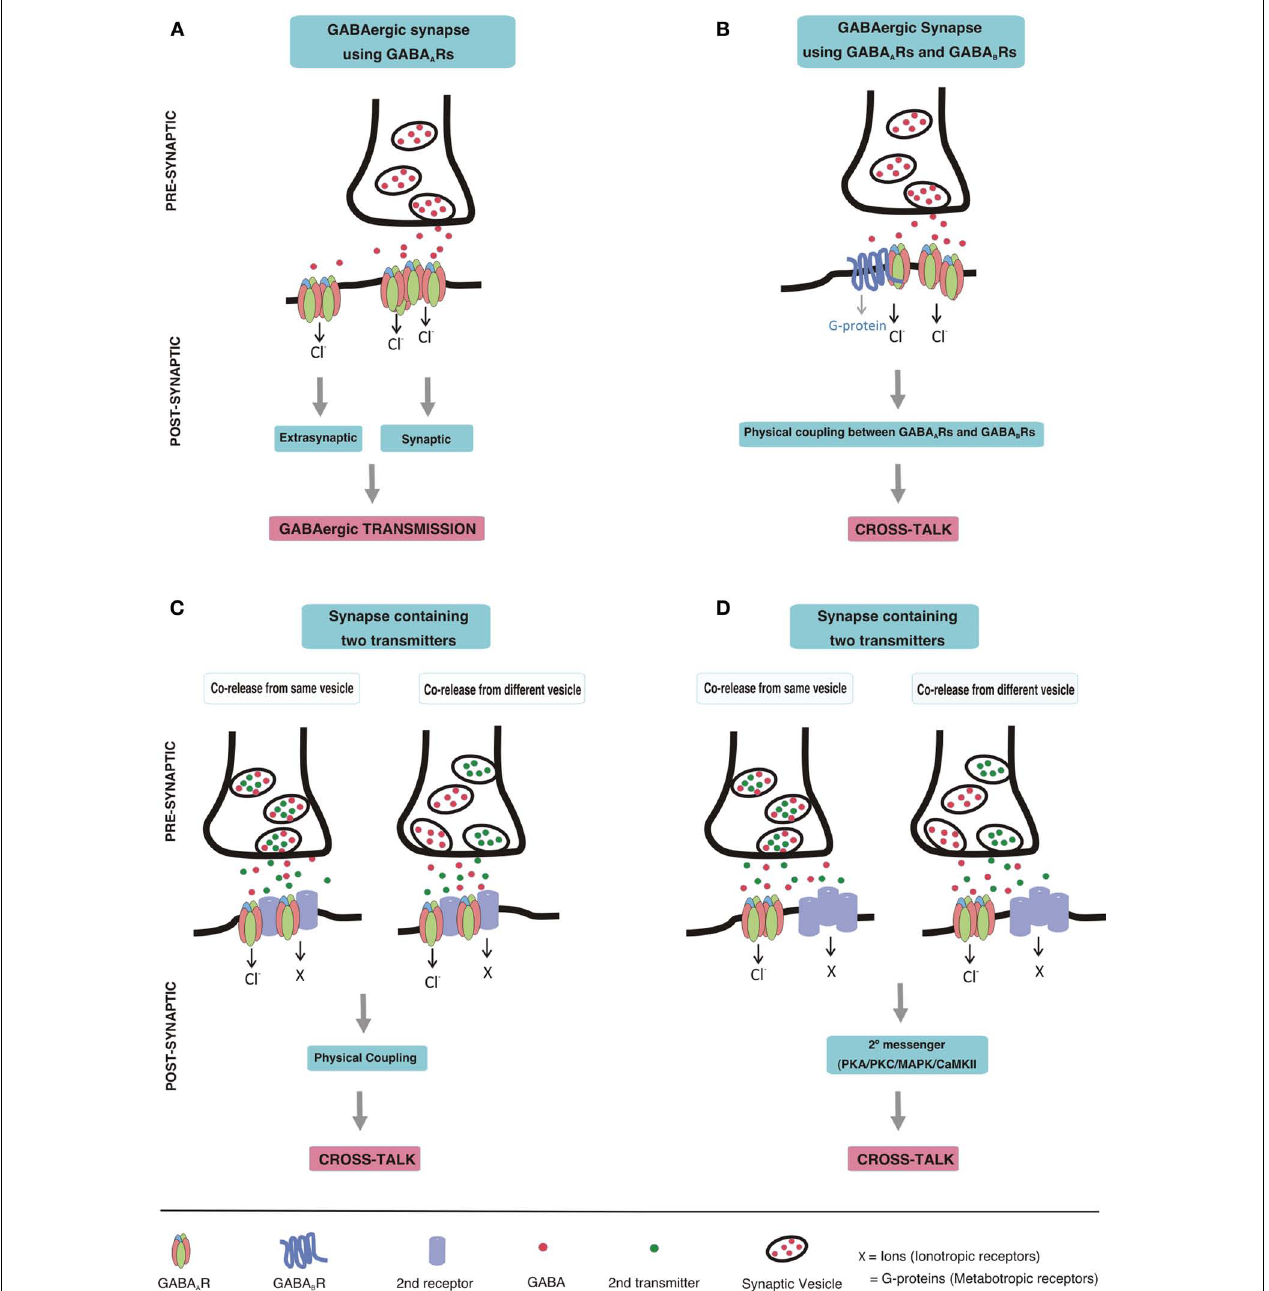
synapses expressing both of these receptors. (C,D) Cross-talk of GABA A Rs with other receptors. Co-release of neurotransmitters from pre-synaptic terminal may occur either from the same vesicles or from different vesicles. Co-released transmitters, then may act on post-synaptically co-localized receptors leading to cross-talk.The cross-talk could be mediated by direct physical coupling of GABA A Rs with other receptors (C) , or by second messenger pathways (D)